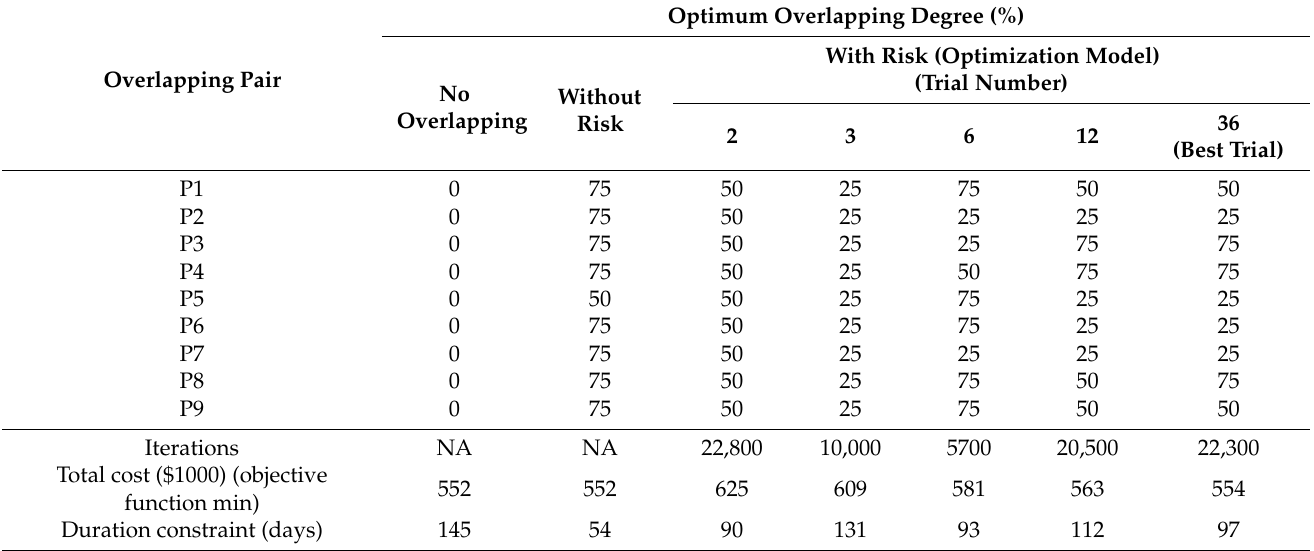
Table 3. Optimum project overlapping degrees. Source